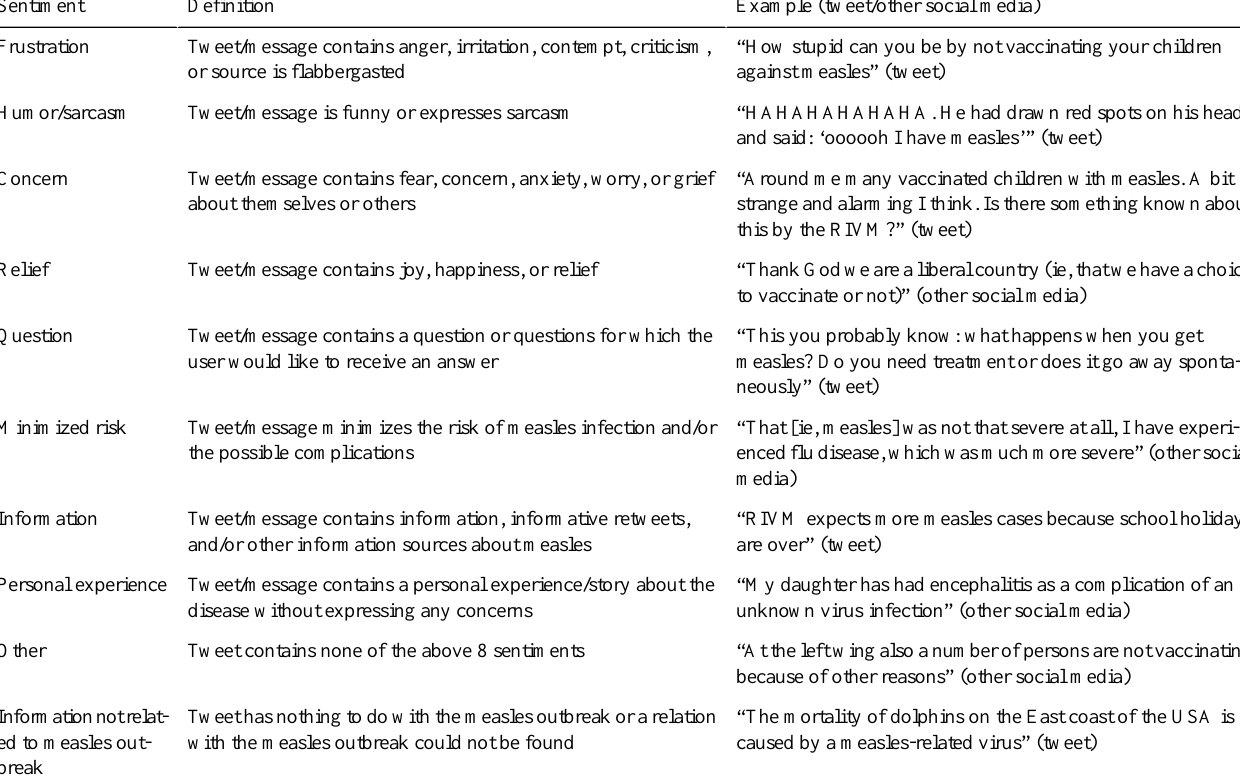
Table 2. Sentiments of tweets and other social media messages about information or frustration.